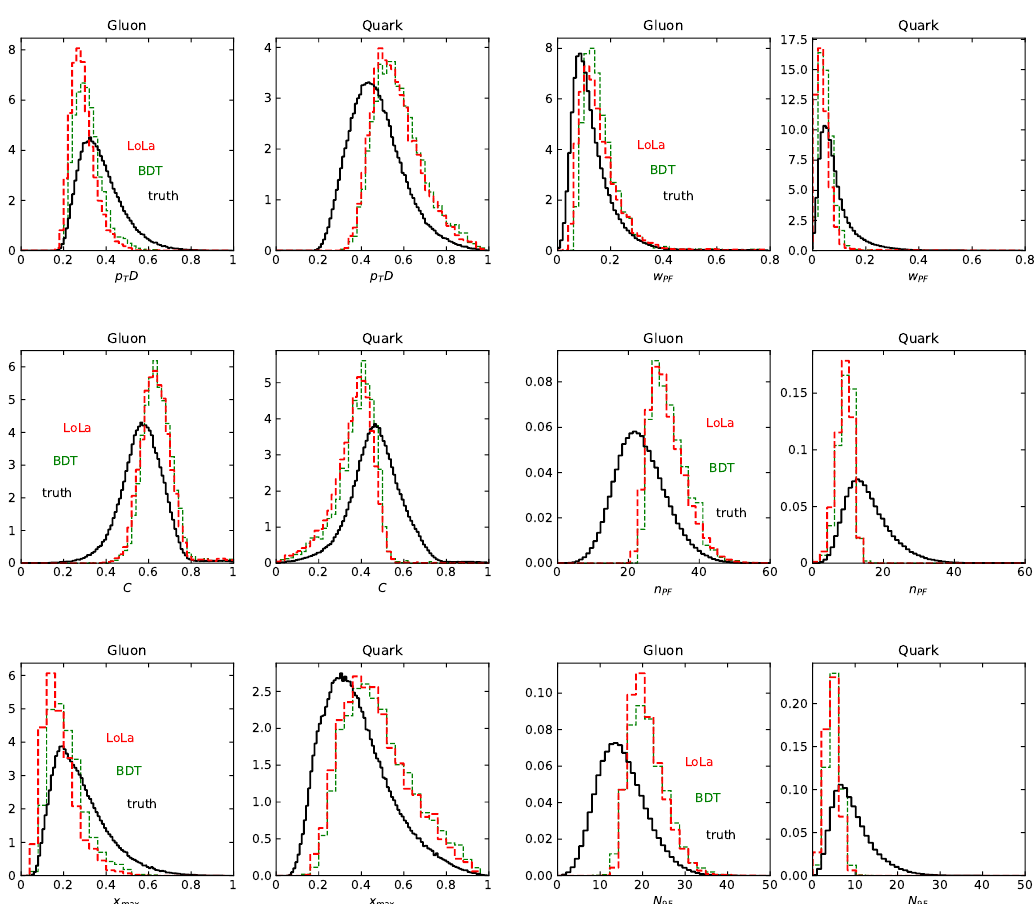
Figure 5: Distributions for the sub-jet observables. The black curves show the truth from Fig. 1. The red dotted curves are the 30% most gluon-like or quark-like jets from L O L A , the green curves from the BDT.